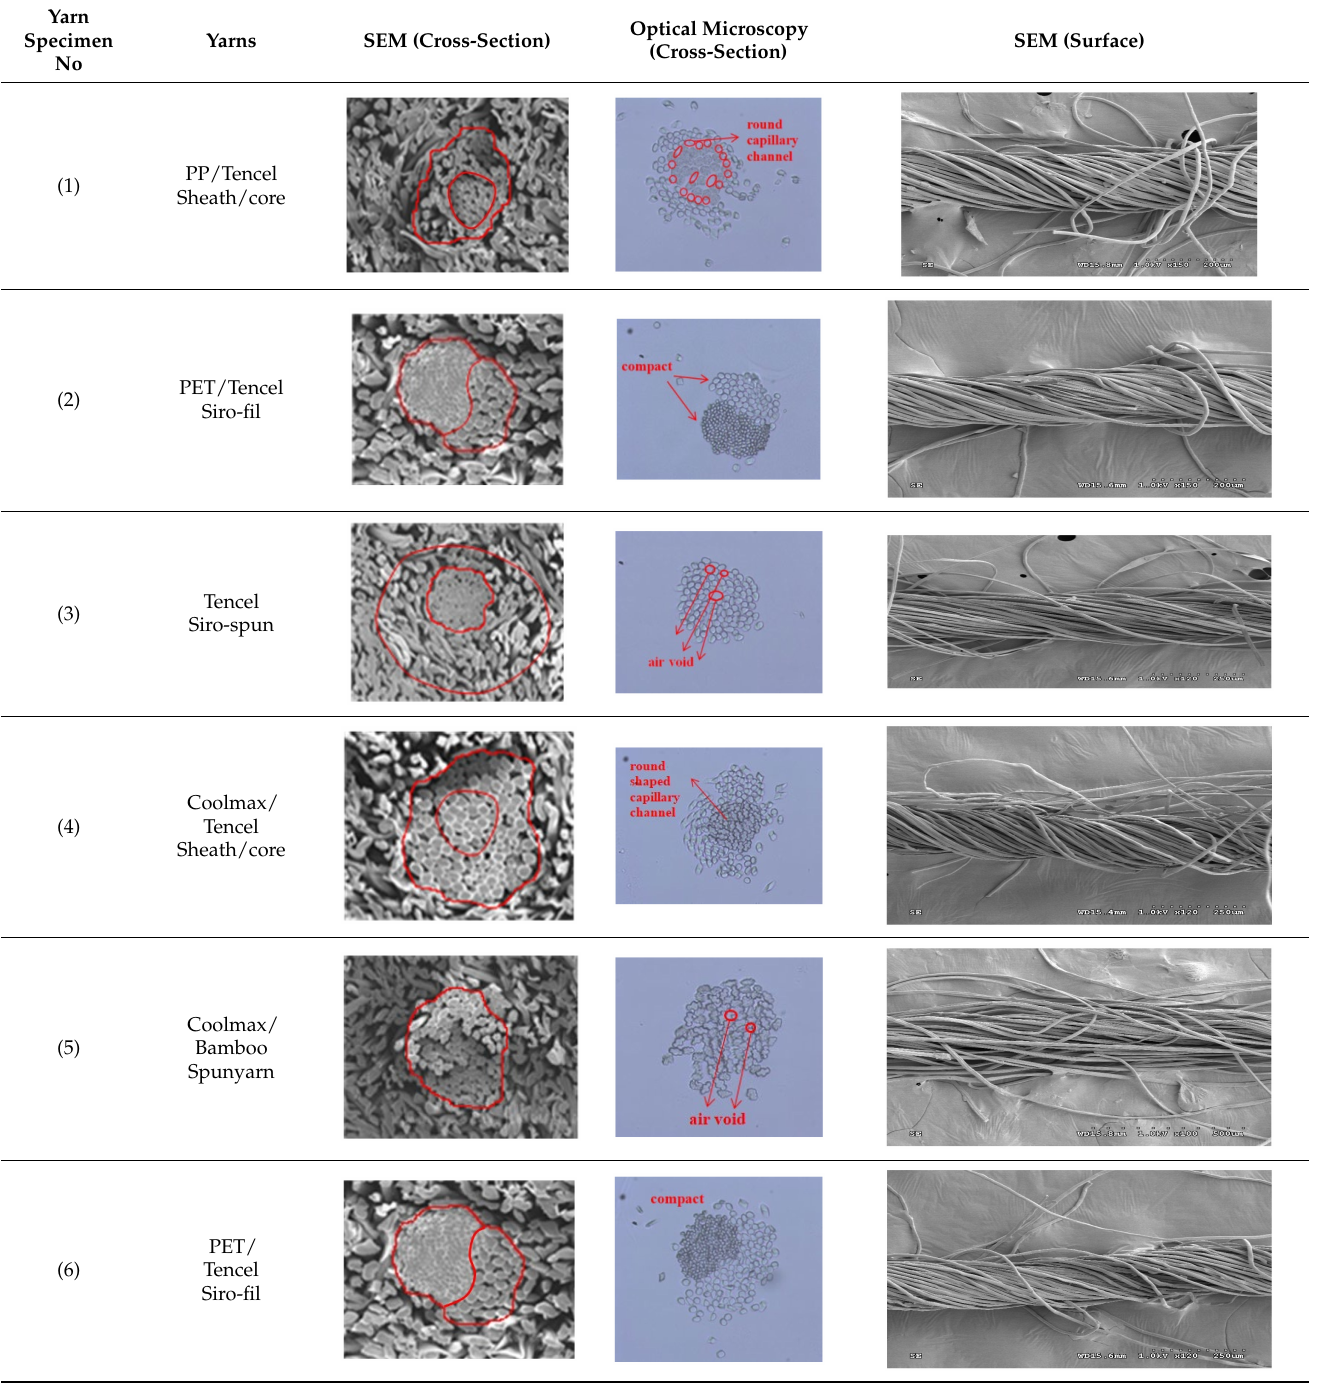
was compared and discussed with its two methods (WVTR and R ef ) for measuring the breathability, as shown in the next section. Table 6. SEM images of cross-sections ( × 500) and surfaces ( × 150) of the yarns and optical microscopy ( × 300) [53]. Yarn